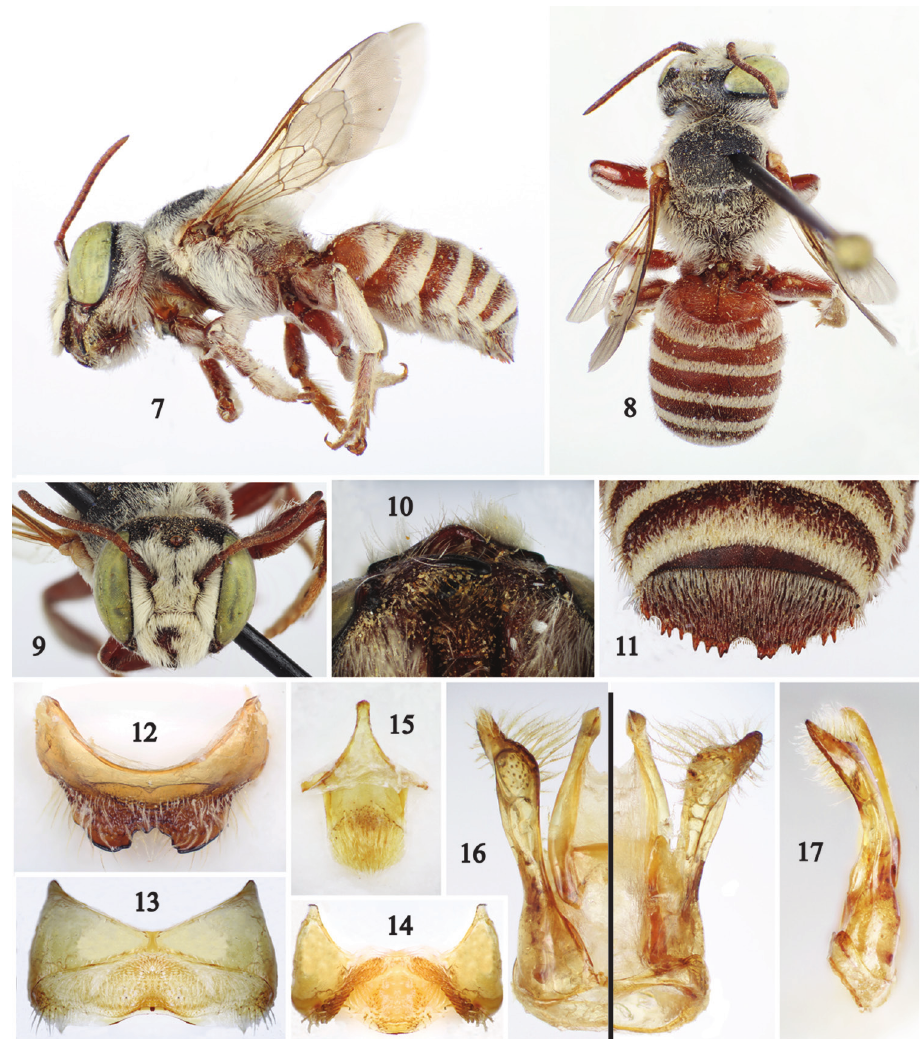
Figures 7–17. Photomicrographs of male paratype (SEMC) of Chalicodoma ( Pseudomegachile ) riyad- hense sp. n. 7 Lateral habitus 8 Dorsal habitus 9 Facial view 10 Ventral view of head 11 Apex of sixth metasomal tergum 12 Seventh tergum 13 Fifth metasomal sternum 14 Sixth sternum 15 Eighth sternum 16 Genital capsule (dorsal left, ventral right) 17 Lateral aspect of genital